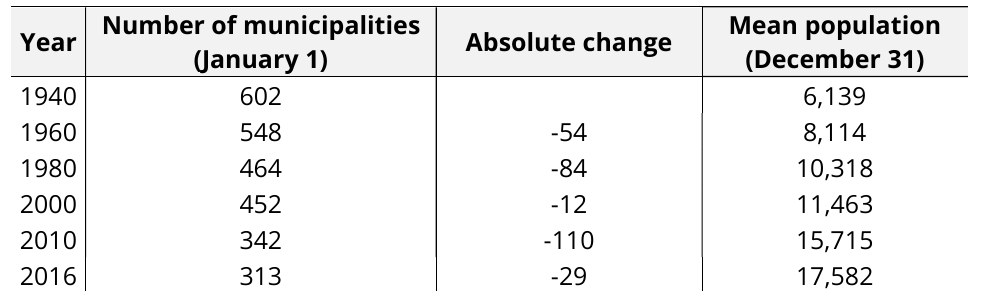
Table 1. Fluctuation in the number of municipalities in Finland (Tilastokeskus